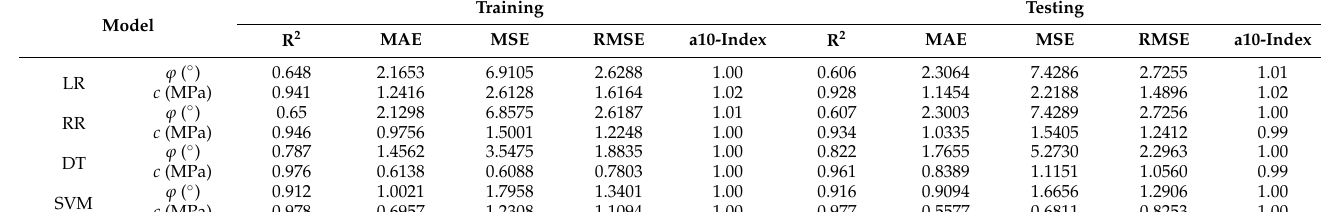
Table 3. Performance indices of ML-based developed models in this study.